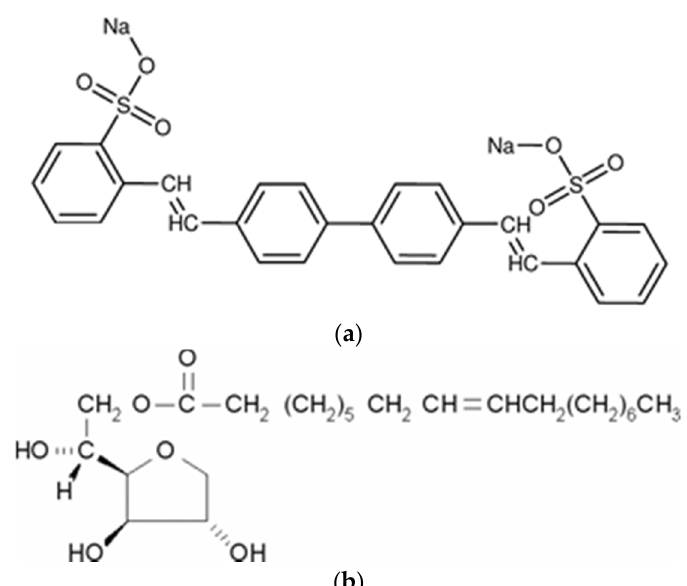
Scheme 1. Structure of the whitening agent ( a ) and the non-ionic surfactant ( b ) .